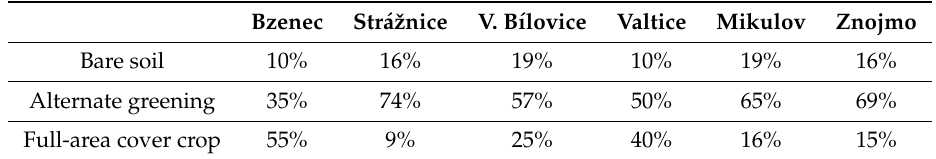
Table 2. The proportion of three types of inter-row management in six observed regions (area of a given type per total area of vineyards in the region).